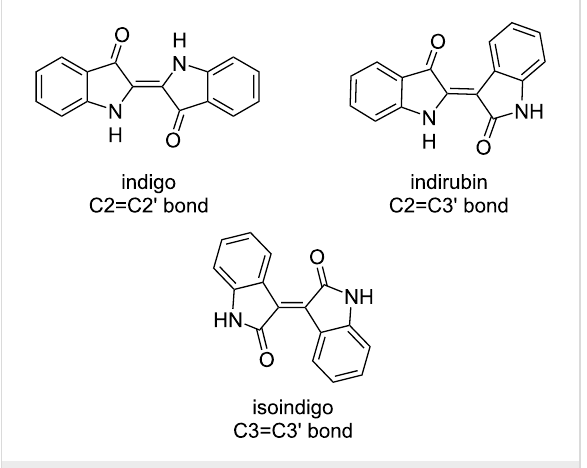
Scheme 1: Representatives of isomeric